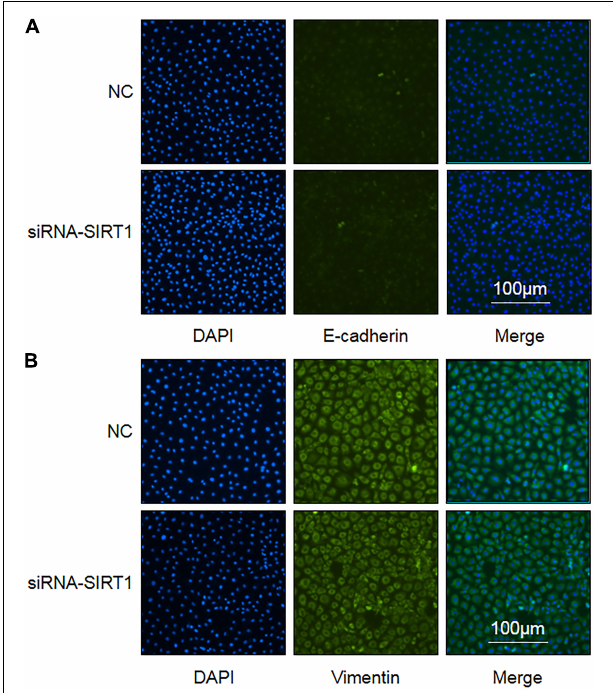
FIGURE 7 | The influence of Sirtuin1 or Silent mating–type information regulation 2 homolog-1 (SIRT1) on the expression of epithelial–mesenchymal transition (EMT) marker proteins in intestinal epithelial cells (IEC). (A) Immunofluorescence staining of E-cadherin protein in control negative (NC) groups and siRNA-SIRT1 group cells (10 × 10). (B) Immunofluorescence staining of Vimentin protein in NC groups and siRNA-SIRT1 group cells (10 ×